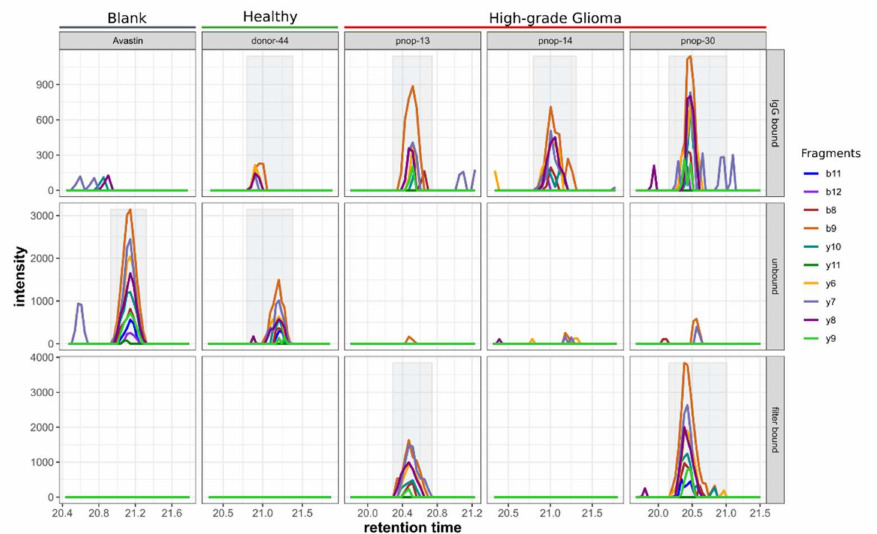
Figure 4. PRM peaks of EGFR peptide GSHQIS[+80]LDNPDYQQDFFPK in the IgG-bound, unbound and filter-bound fractions of one blank sample (Avastin), one healthy control plasma sample and three HGG plasma samples. A fourth HGG plasma sample did show any detectable response of this peptide and was excluded from the analysis (data not shown in figure). Colors in the chromatogram plots indicate the various fragments detected and used for quantification. Gray peak background indicates if a positive peak detection on the basis of at least 3 fragments was